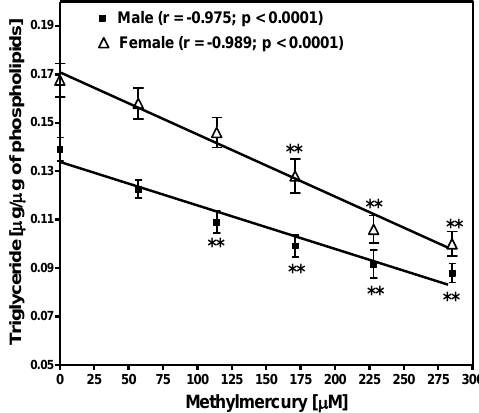
Figure 3. Effect of methylmercury exposure on the levels of triglycerides in male and female flies. Lipids were extracted from twenty male and twenty female flies fed different concentrations of MeHg for four days. After separation of triglycerides by thin layer chromatography, triglycerides levels were measured. Data are presented as Mean ± S.E.M of four independent experiments. ** p < 0.01 as compared to controls, ANOVA (Dunnette).